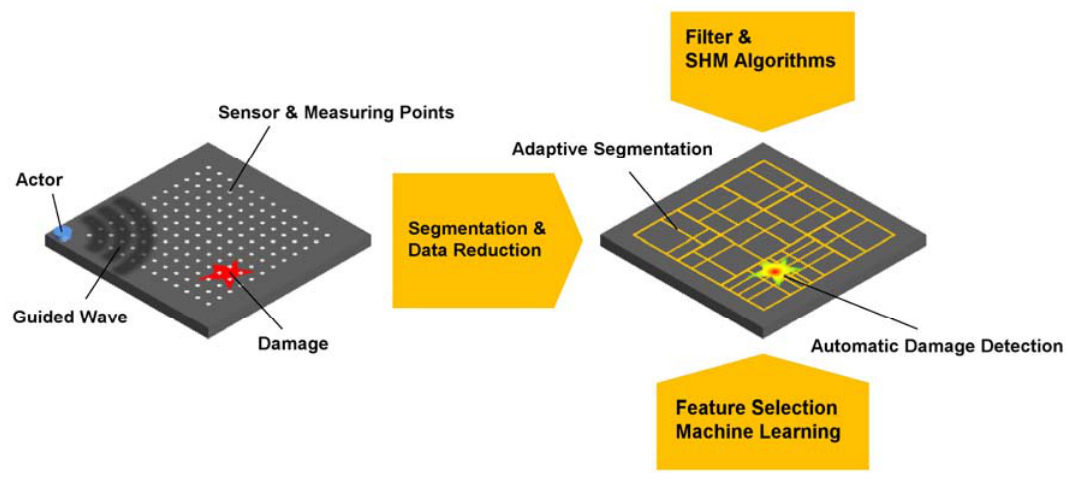
Figure 1. Automated, model ‐ free damage detection with guided ultrasonic waves and 2D